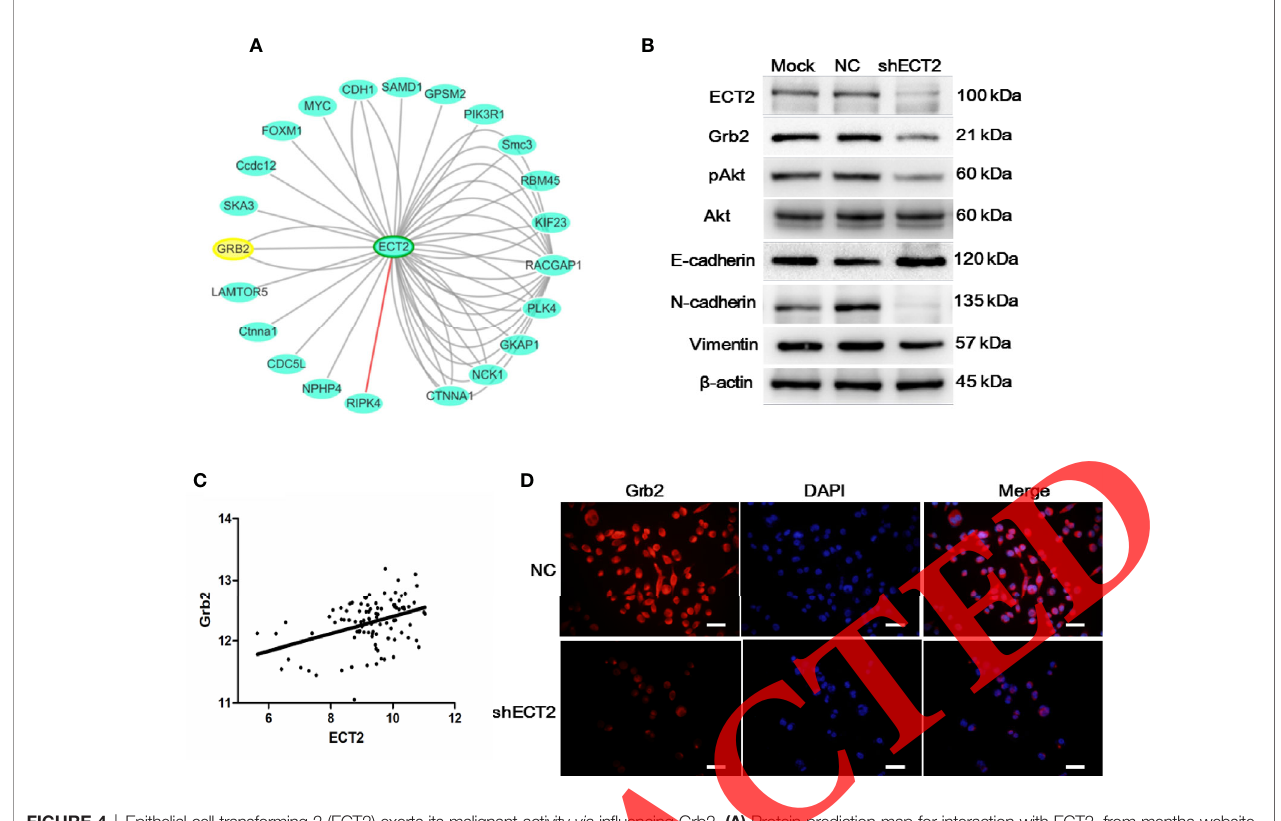
FIGURE 4 | Epithelial cell transforming 2 (ECT2) exerts its malignant activity via in fl uencing Grb2. (A) Protein prediction map for interaction with ECT2, from mentha website. (B) Western blot validated Grb2 protein and downstream signaling was markedly affected in ECT2-KD group. The activity of Grb2 downstream signaling molecules and EMT-relative markers were analyzed by immunoblotting. b -actin was used as a loading control. (C) In Immunohistochemistry results, Grb2 was positively correlated with ECT2 expression(r=0.5068, p<0.01, n=100). (D) Immuno fl uorescence staining showed that pancreatic ductal adenocarcinoma (PDAC) cell lines infected with ECT2-targeting shRNA expressed low levels of Grb2. The nucleus was stained with 40, 6-diamidino-2- phenylindole in the merged images. Scale bar: 100 m